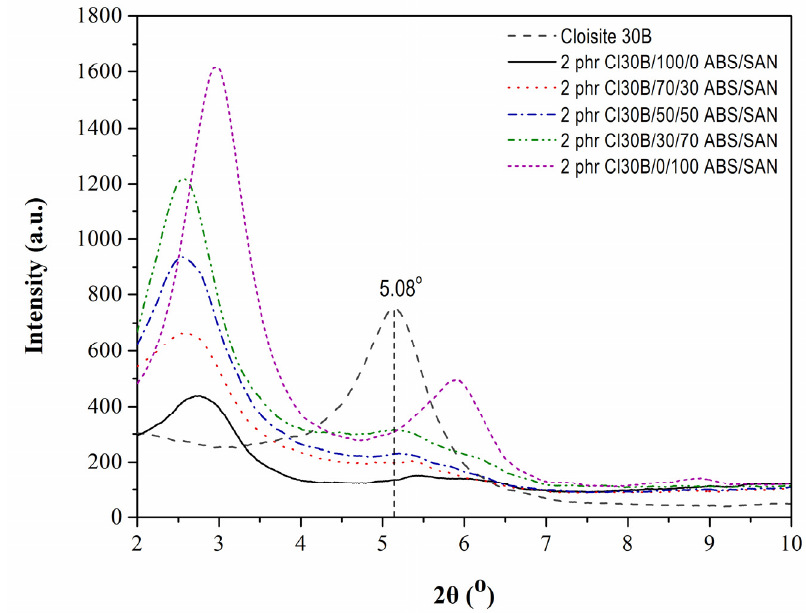
Figure 1. XRD patterns of Cloisite 30B and 2 phr Cloisite 30B/ABS/SAN blend nanocomposites.